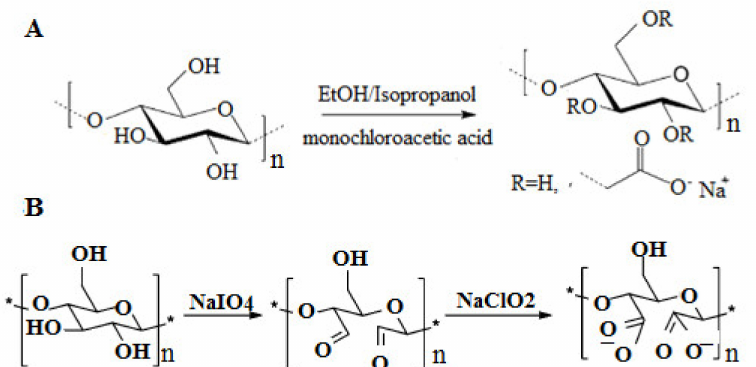
Figure 8. Carboxymethylation pretreatment of cellulose with monochloroacetic acid ( A ). Periodate- chlorite sequential oxidation pretreatment of cellulose fibers ( B